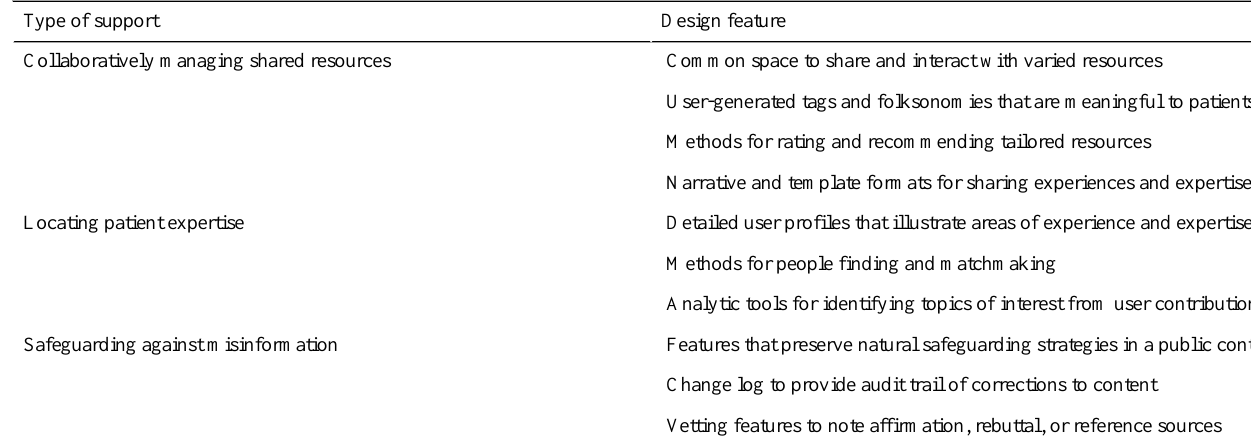
Change log to provide audit trail of corrections to